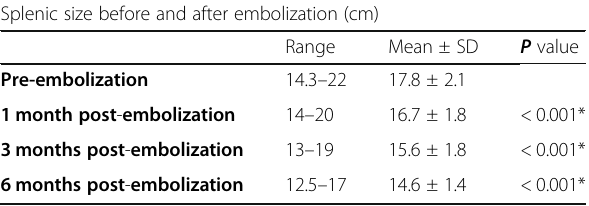
Table 6 Splenic size changes pre- and post-embolization Splenic size before and after embolization (cm)